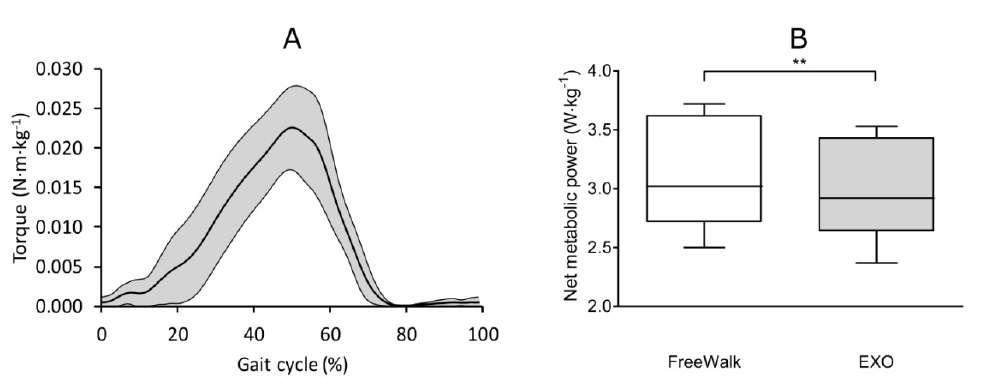
Figure 3. Average torque profile applied by Exoband in the gait cycle ( A ). Net metabolic power in the FreeWalk condition (white) and in the EXO condition (grey) ( B ). ** indicates a significant reduction ( p < 0.01) of the metabolic power using Exoband. Table 1. Spatio-temporal parameters for the two conditions of testing. Data are presented as means ±